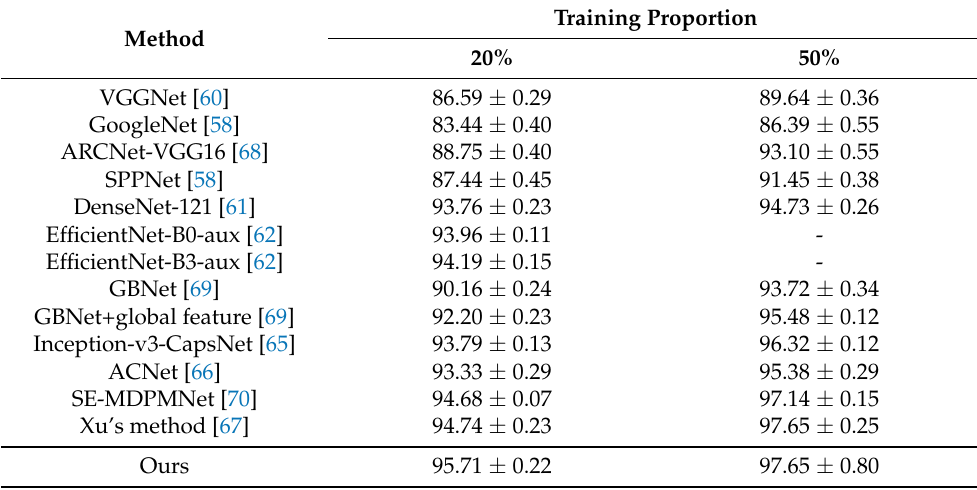
Table 5. Classification accuracy on the AID dataset compared to CNN-based models (OA ± STD).